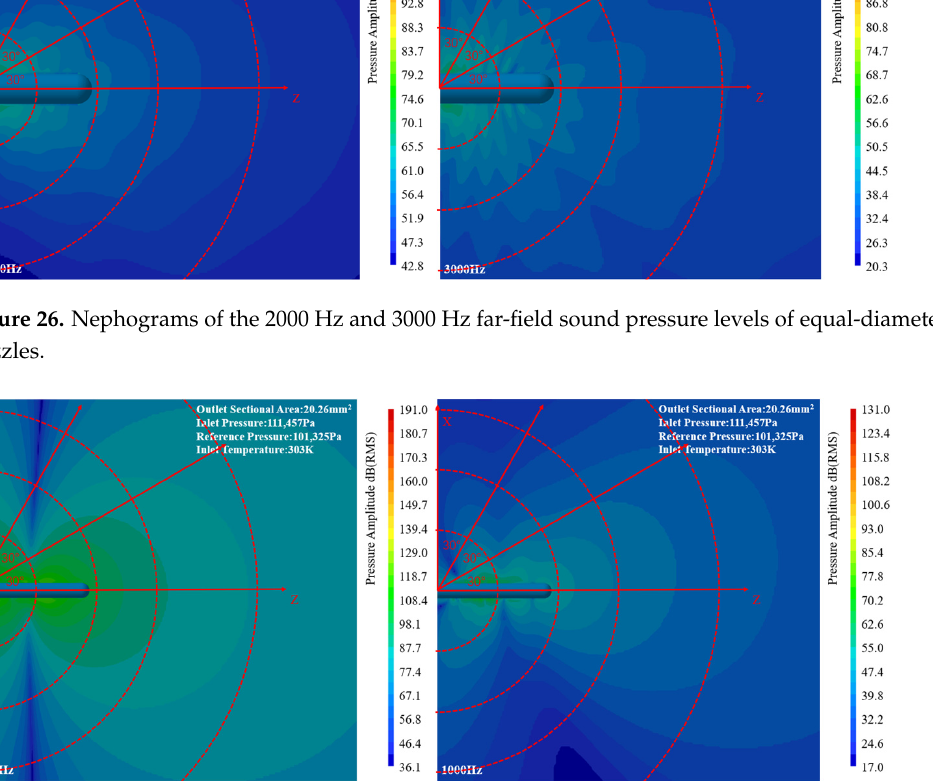
Figure 27. Nephograms of the 100 Hz and 1000 Hz far-field sound pressure levels of standard nozzles.